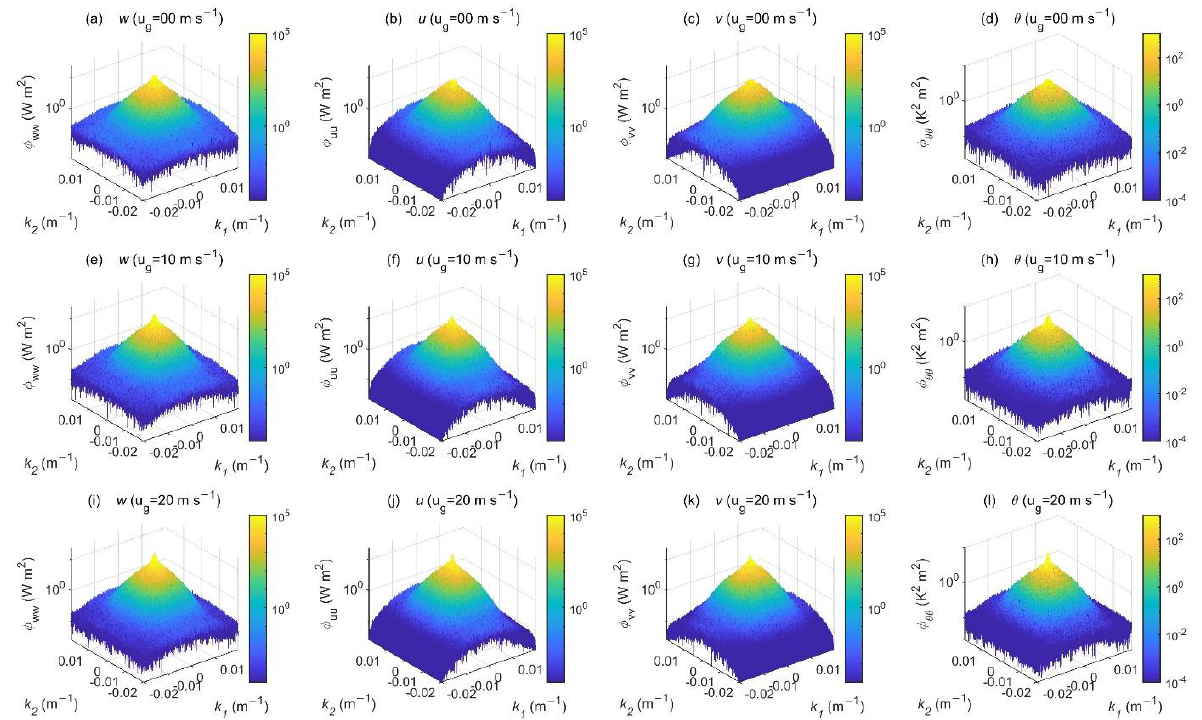
Figure 7. Instantaneous snapshots of w ’s PSD ( 𝜙 𝑤𝑤 , the first column ), u ’s PSD ( 𝜙 𝑢𝑢 , the second column ), v ’s PSD ( 𝜙 𝑣𝑣 , the third column ), and potential temperature θ PSD ( 𝜙 𝜃𝜃 , the last column ) from LES simulations at z / z i = 0.5 and 3 h of physical time across the range of U g . First row U g = 0 ms −1 ; second row U g = 10 ms −1 ; third row U g = 20 ms −1 . The x -coordinate represents the 𝑘 1 wave- number, y -coordinate the 𝑘 2 wavenumber, and the z -coordinate the PSD. Note that the PSDs of 𝜙 𝑤𝑤 , 𝜙 𝑢𝑢 𝜙 𝑣𝑣 , and 𝜙 𝜃𝜃 are scaled by the logarithm for clarity and contrast (i.e., log 10 𝜙 𝑤𝑤 , log 10 𝜙 𝑢𝑢 , log 10 𝜙 𝑣𝑣 , log 10 𝜙 𝜃𝜃 ).